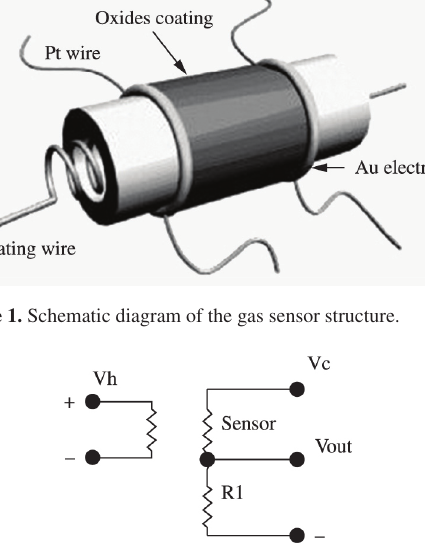
Figure 2. Schematic of the test system.